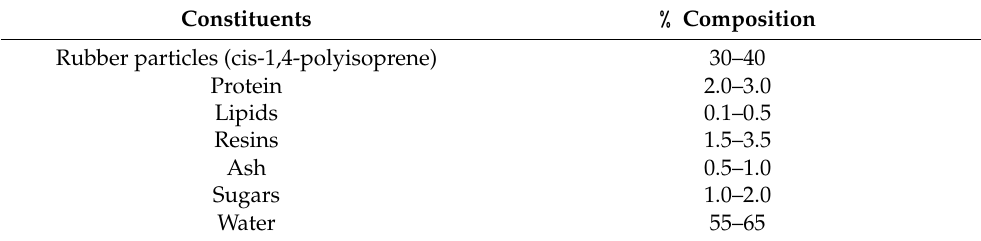
Table 1. Composition of fresh natural rubber latex